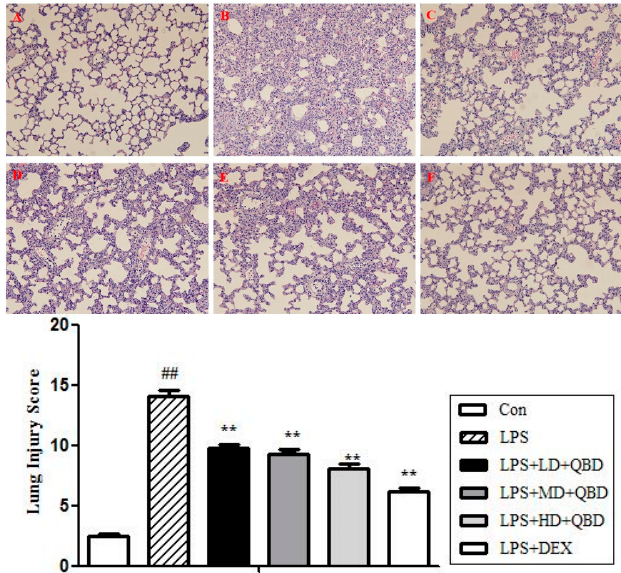
Figure 2. QBD ameliorated LPS-induced histological changes in the lung. Representative lung sections